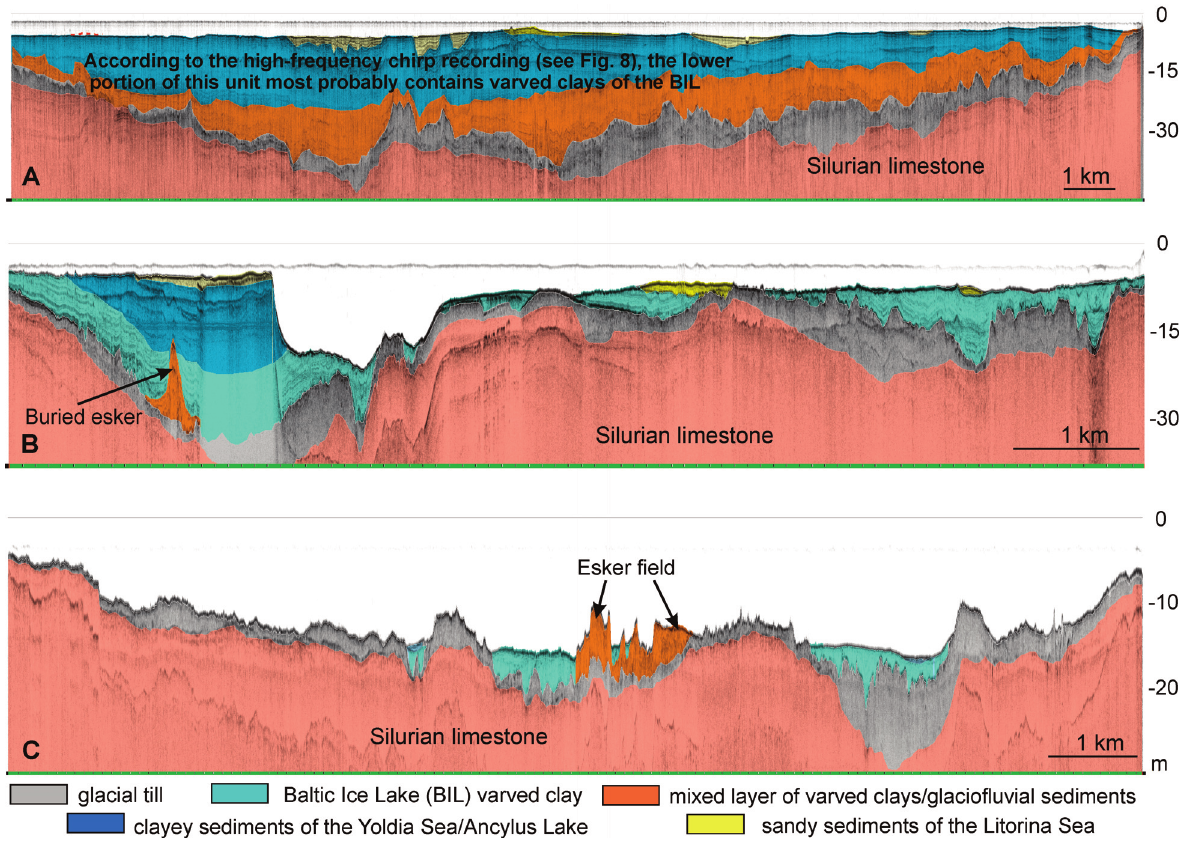
Fig. 7. Interpreted boomer-type seismo-acoustic profiles from the northern (A), middle (B) and southern (C) parts of our study area (for the locations, see profiles 1, 2, 3 in Fig. 1B, respectively). For the location of the esker field in profile C, see rectangle B in Fig.